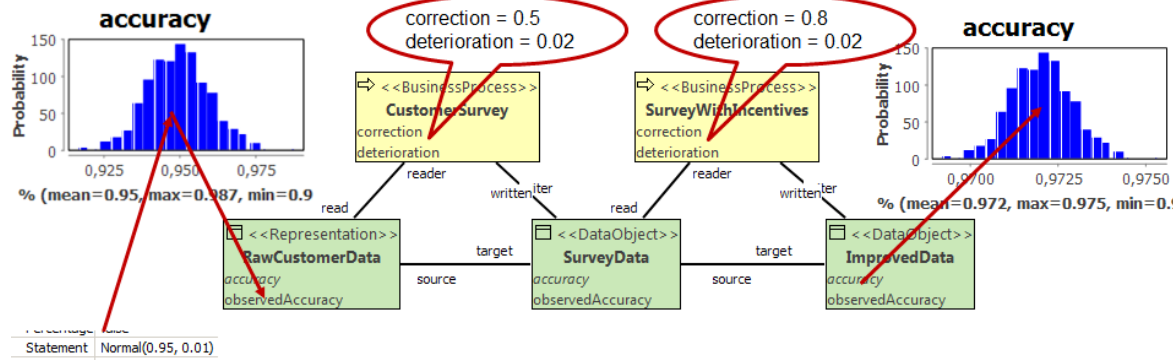
Figure 6. A simple MAPL accuracy